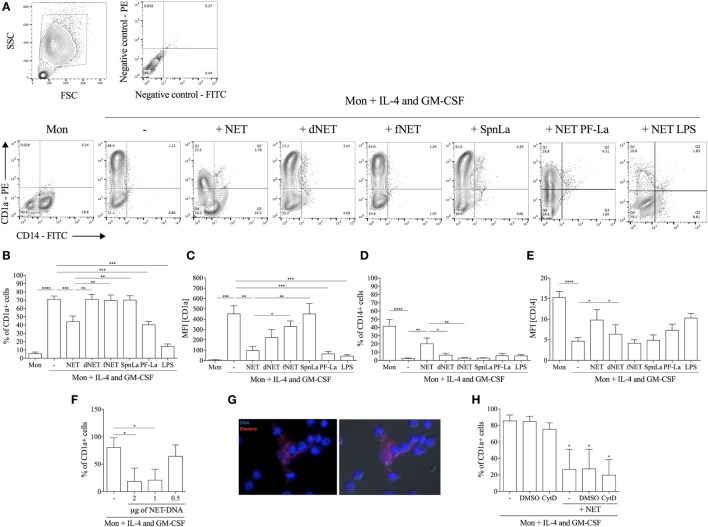
Neutrophil extracellular traps (NETs) impair fully differentiation of monocytes into dendritic cells. Adhered monocytes were incubated or not with NETs-enriched supernatants, which were treated or not with DNase, or filtered for 18 h. IL-4 and GM-CSF were added to the cultures (as indicated), which were maintained at 37°C/5%CO2. After 5 days, cells were harvested and stained for CD1a (B,C) and CD14 (D,E) and analyzed on a FACSCalibur flow cytometer. (A) Contour plots of one representative experiment showing the gate strategy. (B–E) The column Mon means that the adhered monocytes were not treated with NETs nor IL-4/GM-CSF. Digested NET (dNET) means supernatants enriched in NET pretreated with DNase (10 U/mL) 30 min before addition to monocytes. fNET means NET-free supernatants filtered through a 0.22 µm pore filter. PF-La and lipopolysaccharide (LPS) mean supernatants enriched in NET produced by paraformaldehyde killed parasites or LPS-activated neutrophils, respectively. Results of at least six independent experiments are shown as mean ± SEM. (B) ****, ***, **P < 0.01. (C) ***, **P < 0.01; *P < 0.05. (D) ****, **P < 0.01; *P < 0.05. (E) ****P < 0.01; *P < 0.05. (F) Adhered monocytes were incubated or not with different concentrations of NETs-enriched supernatants and the percentage of CD1a+ cells were analyzed as in panels (A–E). Results of three independent experiments are shown as mean ± SEM. *P < 0.05 related to monocytes only incubated with IL-4/GM-CSF (first column). (G) Adhered monocytes were incubated with NETs-enriched supernatants for 4 h at 37°C/5%CO2. Cells were fixed and stained for DNA (blue) with 4′,6-diamidino-2-phenylindole and with anti-elastase followed by Texas red-labeled secondary antibody. Left image shows the overlay of DNA and elastase staining and right image shows the overlay of DNA and elastase staining with differential interference contrast image. (H) Monocytes were pretreated with cytochalasin D for 30 min before the addition of NETs and the percentage of CD1a+ cells were analyzed as in panels (A–E). Results of four independent experiments are shown as mean ± SEM. *P < 0.01 related to monocytes only incubated with IL-4/GM-CSF (first column).